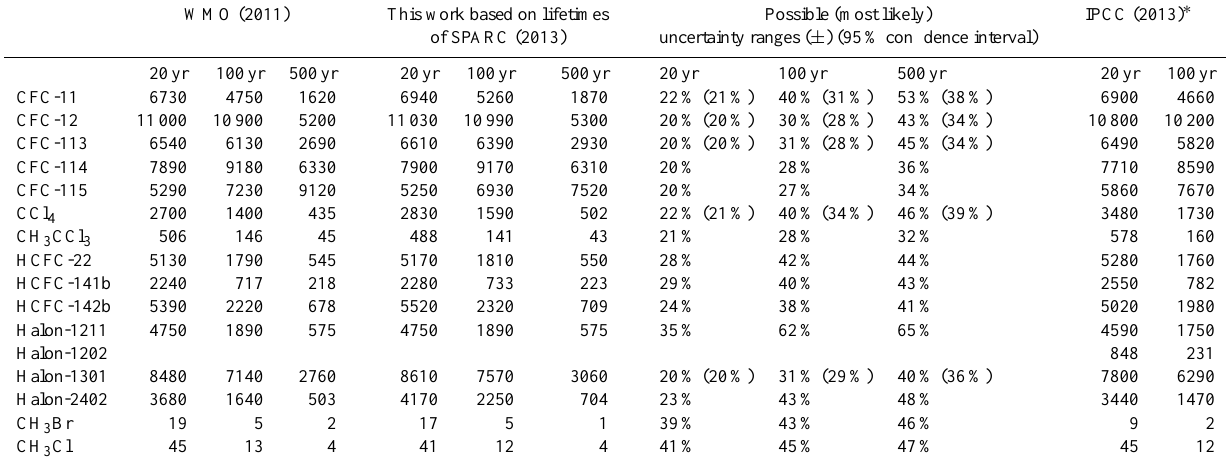
Table 4. GWPs and their uncertainties. The GWPs shown are the values reported in WMO (2011) and the values and uncertainties calculated here using the same radiative efficiencies and absolute GWPs of CO 2 , but the lifetimes from SPARC (2013). The GWPs of IPCC (2013) are also given for